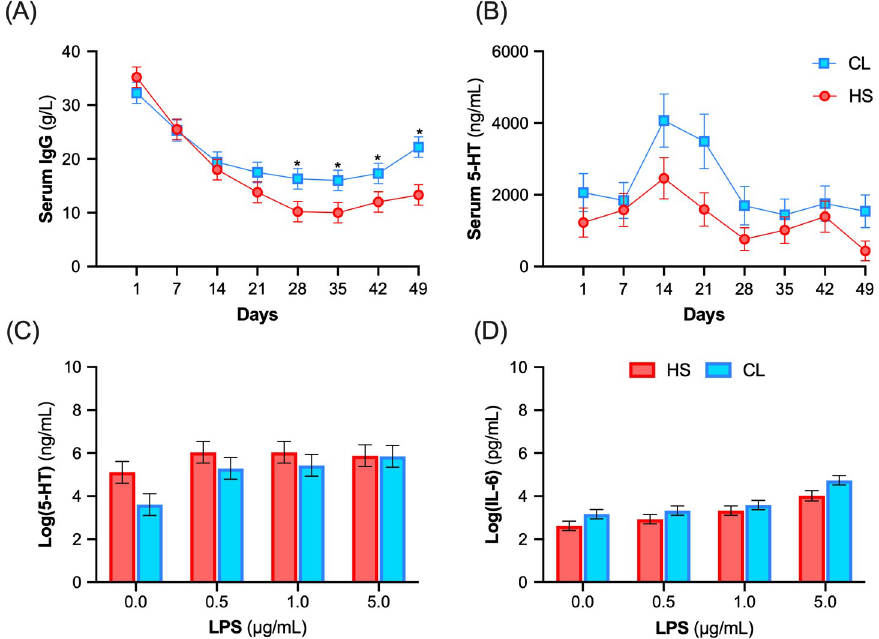
Fig 3. Weekly serum IgG and serotonin concentrations and whole blood production of serotonin and interleukin 6 after in vitro LPS-challenge. Serum ( A ) IgG and ( B ) serotonin (5-HT) concentrations of calves from d 1 to d 49 postnatal. ( C ) Log-transformed serotonin (5-HT), and ( D ) log-transformed interleukin-6 (IL-6) concentrations 24-h after ex vivo blood stimulation with increasing doses of lipopolysaccharide (LPS, 0, 0.5, 1 and 5 μ g/mL) at postnatal d 47. Calves were exposed to heat stress (HS, shade: n = 6) or heat stress abatement (CL, shade plus fans; n = 6) across pre- and postnatal periods (late gestation and pre-weaning). Blue squares denote CL treatment, and red circles denote HS treatment. There was a treatment by day interaction for serum IgG concentrations ( P = 0.05), but no interaction effects for serum 5-HT concentrations ( P = 0.38), and plasma supernatant concentrations of 5-HT ( P = 0.54) or IL-6 ( P = 0.76). Concentrations of 5-HT and IL-6 were log-transformed for analysis due to a lack of normality. Back transformed data are presented in S2 Table. Asterisk ( � ) indicate significance ( P � 0.05).